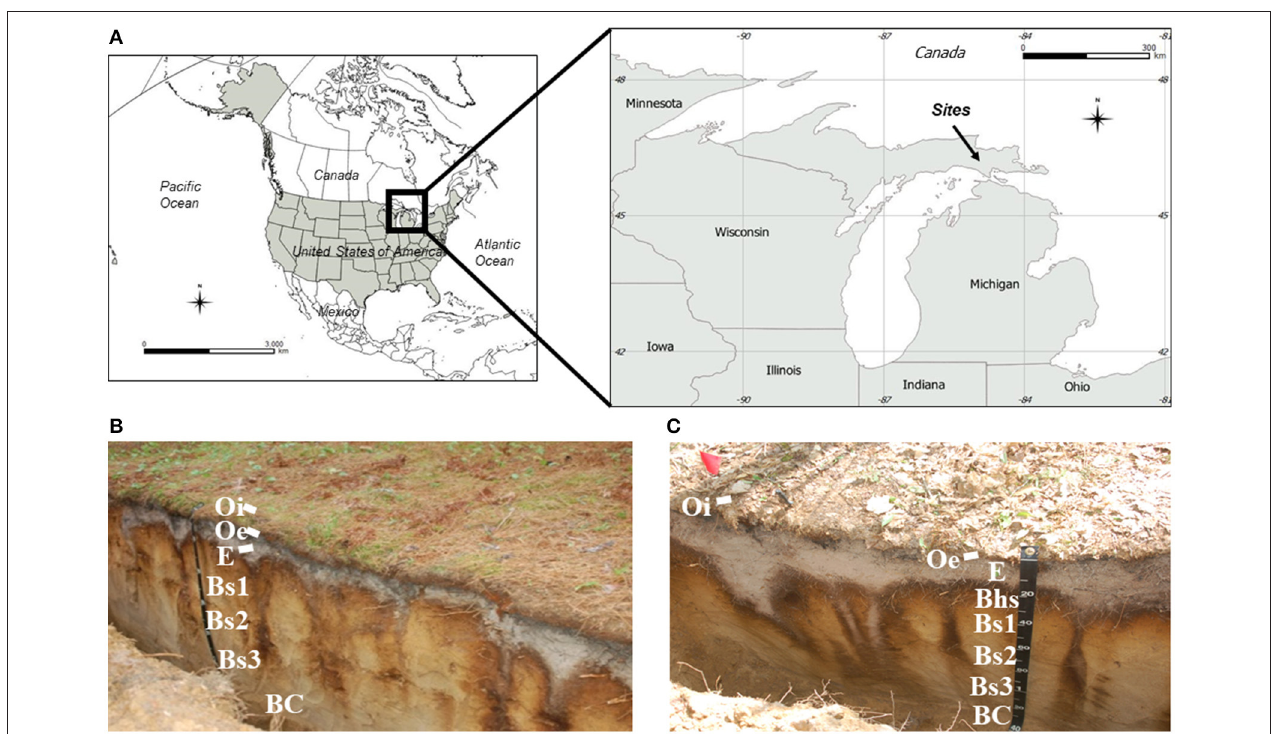
FIGURE 1 | Map showing the location of the sites in the eastern Upper Peninsula of Michigan (USA), (A) and schematic figures of soil vertical profiles typically found in 100-year burned (B) and unburned sites (C) . Spodic horizons: Bs, sesquioxides of Al and Fe; and Bhs, mixture of Bs and Bh (organic matter